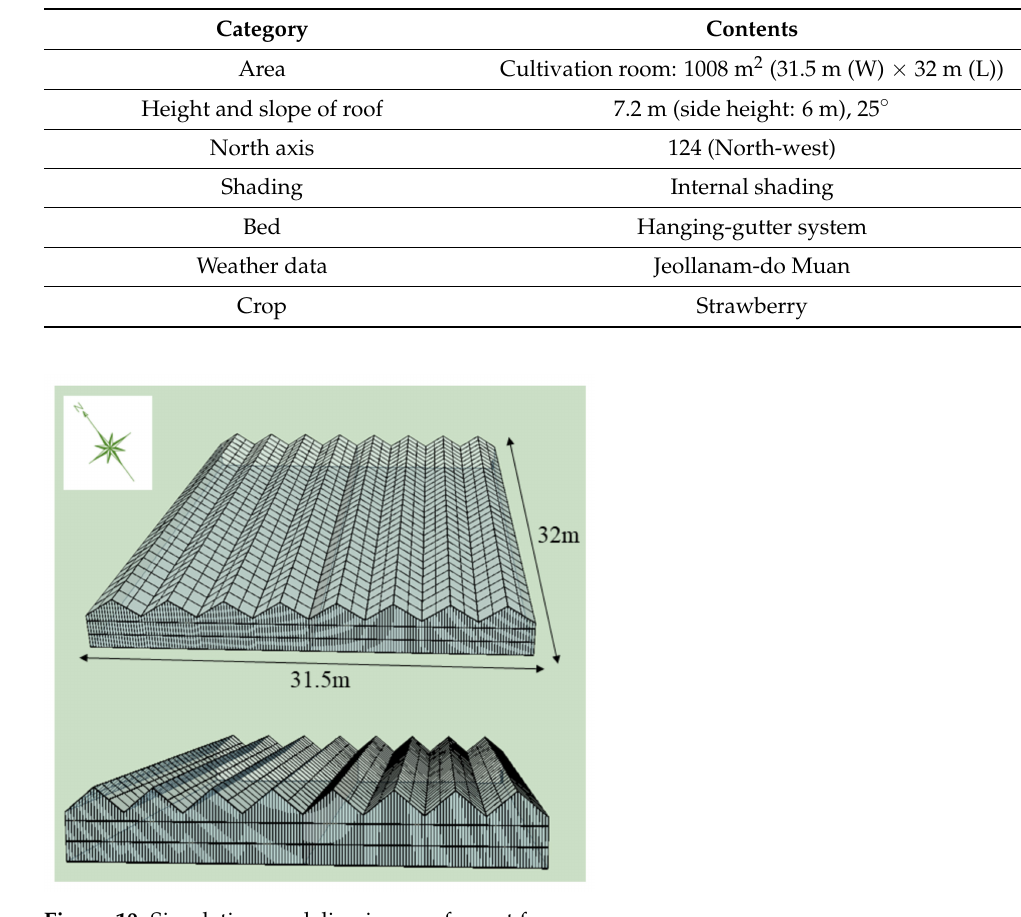
Figure 10. Simulation modeling image of smart